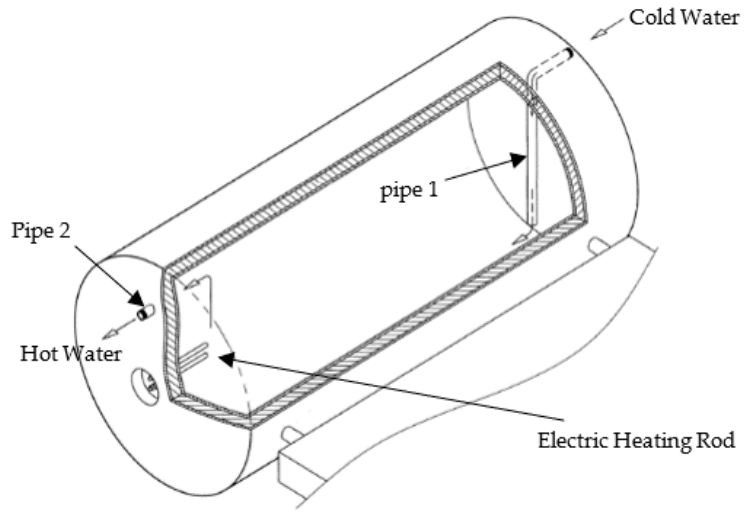
Figure 2. Cross-section view of a conventional 1st generation solar water heating tank [18].